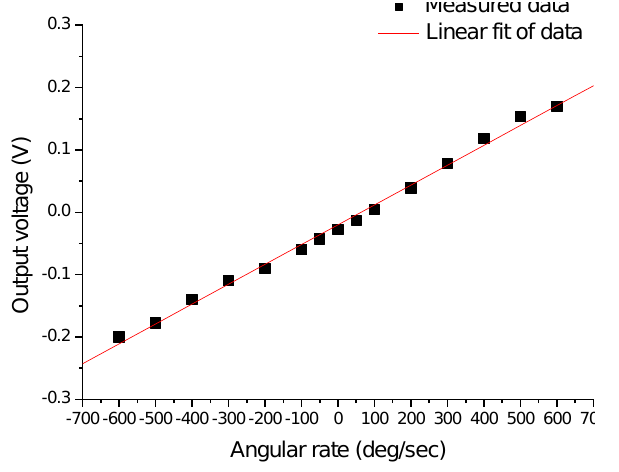
Figure 6. Output voltage of the sensor versus the angular rate applied around the Z-axis.